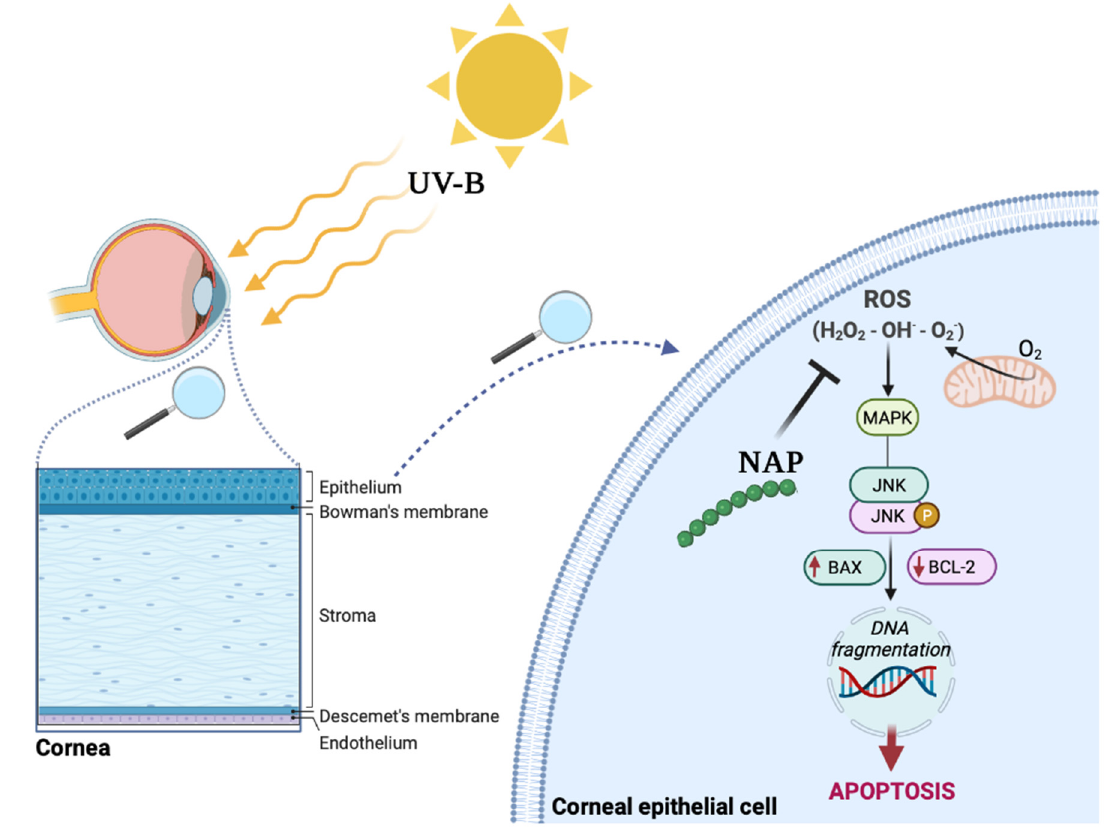
Figure 8. Protective effects of NAP on corneal epithelium exposed to UV ‐ B radiation. Schematic representation of NAP effect on ROS formation, indirectly inducing downregulation of JNK/Bax signaling pathways.